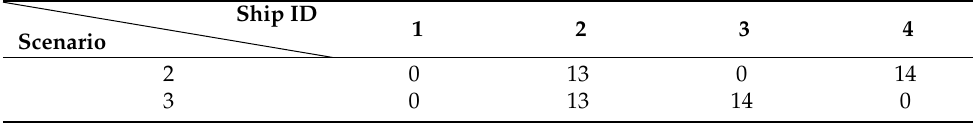
Table 11. Example 2—final duration for Strategy 2a (h).